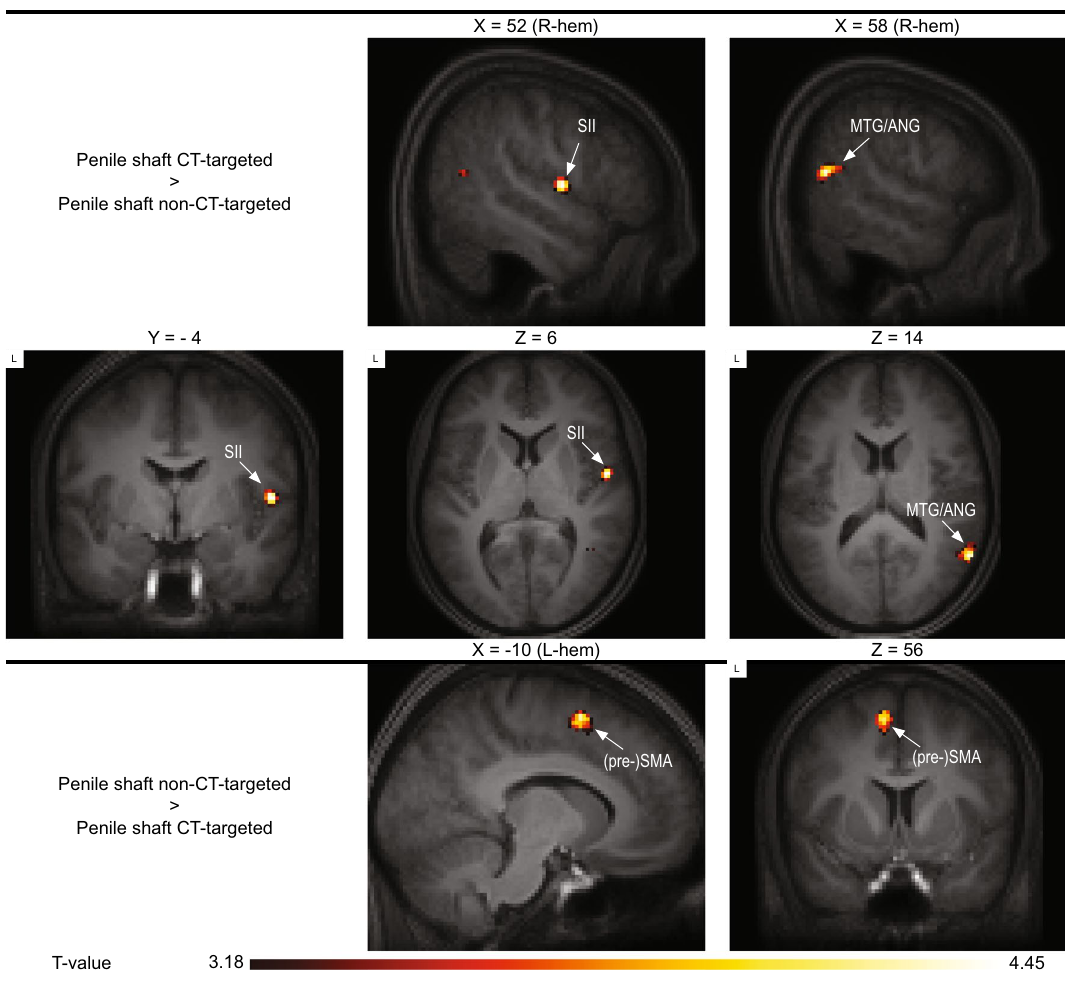
Figure 3. Group level results of the comparison contrast between CT-targeted touch and non-CT-targeted touch of the penile shaft. The template was created by averaging the structural T1-scans of the 19 participants. Results are presented at an uncorrected threshold of p < 0.001. Abbreviations: angular gyrus (ANG), middle temporal gyrus (MTG), (pre-)supplementary motor area (pre-SMA), secondary somatosensory cortex (SII). FMRI sections were created using FSLeyes (v. 1.3.3; https:// fsl. fmrib. ox. ac. uk/ fsl/ fslwi ki/ FSLey es). Final figure was created using Adobe InDesign 2022 for Mac (v. 17.2; https:// www. adobe. com/ produ cts/ indes ign.